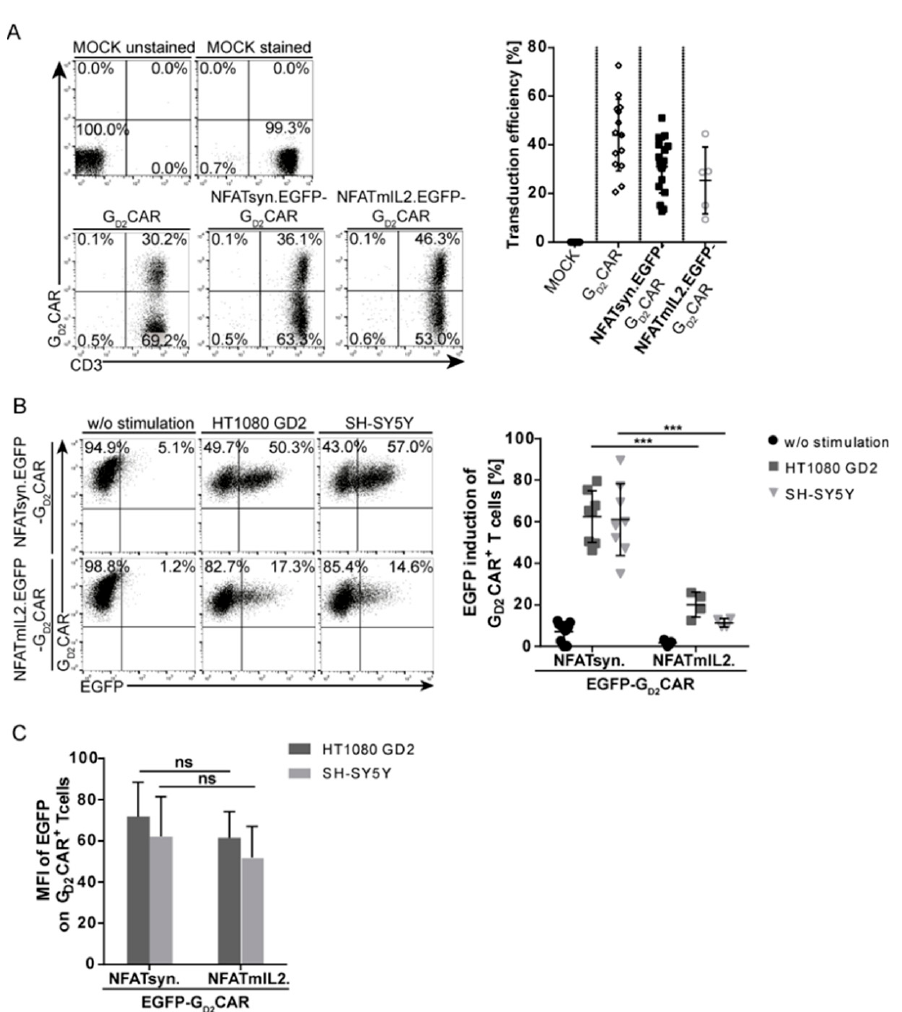
Figure3. Promoterchoiceiscriticalfortheamountofinducibletransgeneexpression. ( A Figure 3. Promoter choice is critical for the amount of inducible transgene expression. ( A ) Representative flow cytometric analysis of primary human transduced CD3 + T cells. Transduction efficiencies were determined six days post transduction via a G D2 CAR-specific antibody that recognizes the scFv region. The graph summarizes transduction efficiencies of the individual “all-in- one” constructs (NFATsyn.EGFP-G D2 CAR or NFATmIL2.EGFP-G D2 CAR) in primary human T cells (multiplicity of infection (MOI) 10). Shown are mean values ± SD (symbols indicate individual donors; n = 5–18). ( B ) Comparison of inducible promoters, namely NFATsyn and NFATmIL2. Primary human T cells were transduced with “all-in-one” EGFP constructs (NFATsyn.EGFP-G D2 CAR or NFATmIL2.EGFP-G D2 CAR), sorted, and co-cultured with GD2 + target cells. Both constructs drive NFAT promoter-regulated EGFP expression upon G D2 CAR-specific activation. Representative flow cytometric analysis of NFAT-driven EGFP expression in transduced T cells after 24 h co-culture with a 6:1 effector/target (E/T) ratio. The graph summarizes multiple experiments of NFAT promoter- driven EGFP expression in “all-in-one” construct-positive (G D2 CAR + ) T cells post stimulation with GD2 + target cells. Shown are mean values ± SD; symbols indicate individual co-culture experiments with individual donors; n = 4–8. Indicated statistical significance was determined by one-way intensity (MFI) of inducible NFAT promoter-driven EGFP in “all-in-one” construct-positive